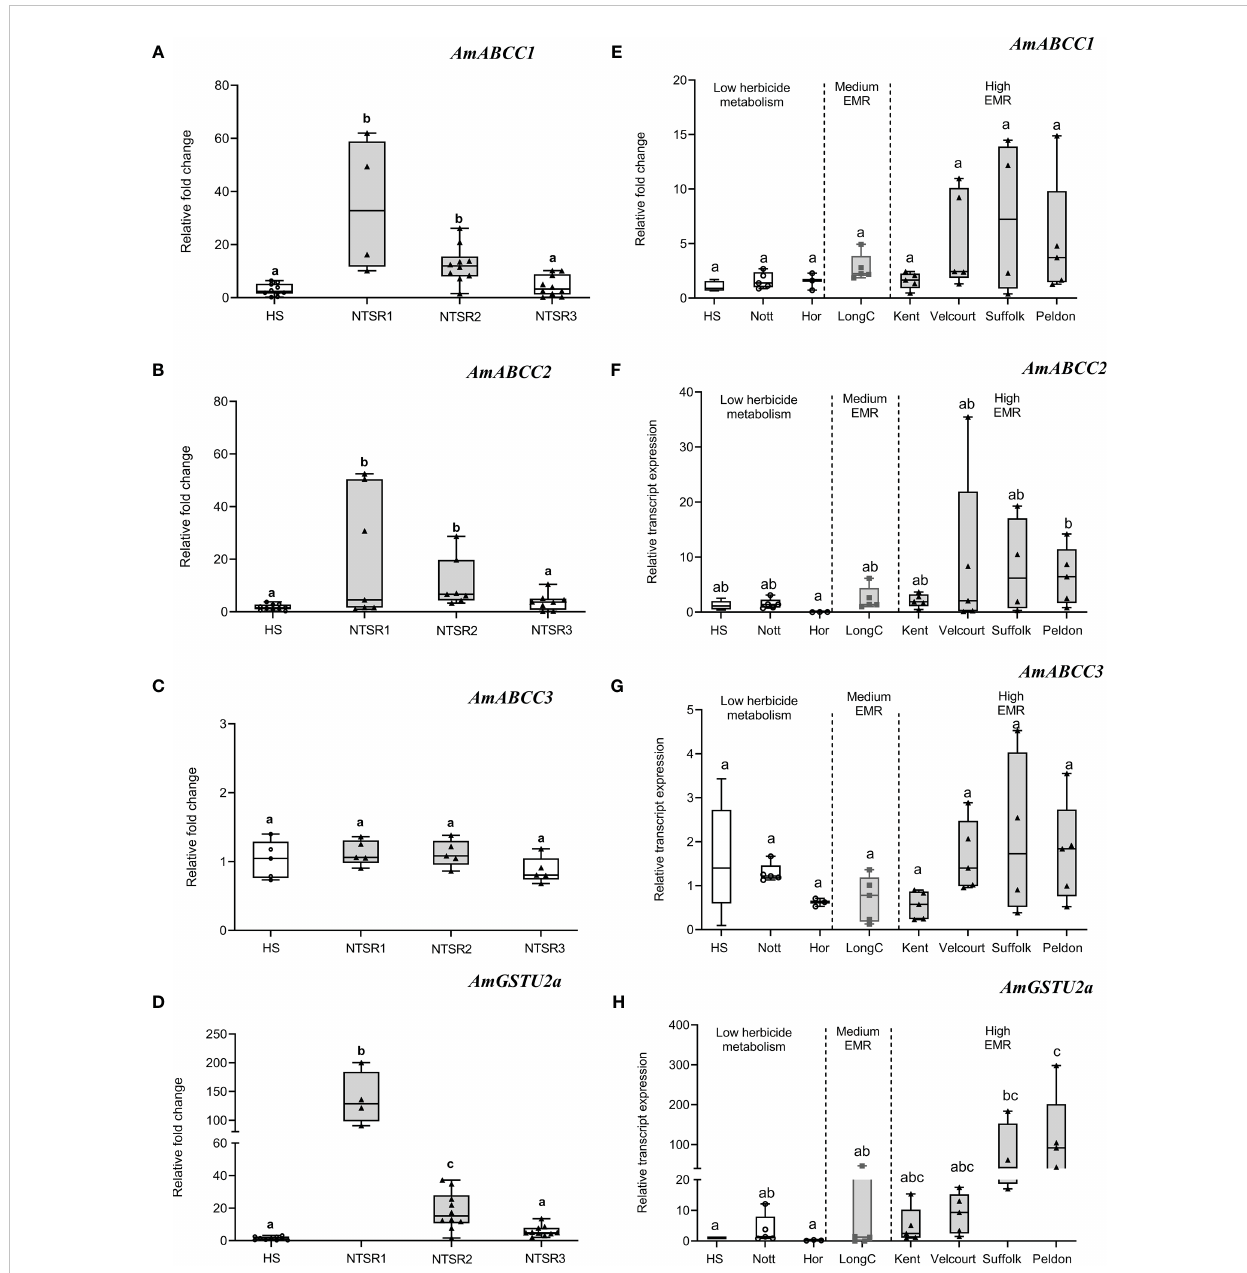
FIGURE 2 Basal relative transcript expression of AmABCCs and AmGSTU2a in NTSR and HS blackgrass populations. (A – D) The expression of AmABCC1 , AmABCC2 , AmABCC3 and AmGTSU2a were quanti fi ed by qRT-PCR in HS and three NTSR blackgrass populations exhibiting the three subtypes of NTSR (Te ́ tard-Jones et al., 2018). Box plots represent relative transcript expression (n=5) of each gene in HS, NTSR1. NTSR2 and NTSR3 populations. (E – H) Box plots represent the expression of AmABCCs and AmGTSU2a (n=3-5) in fi eld-derived blackgrass populations of de fi ned EMR phenotypes. The different letter represent statistically difference among blackgrass